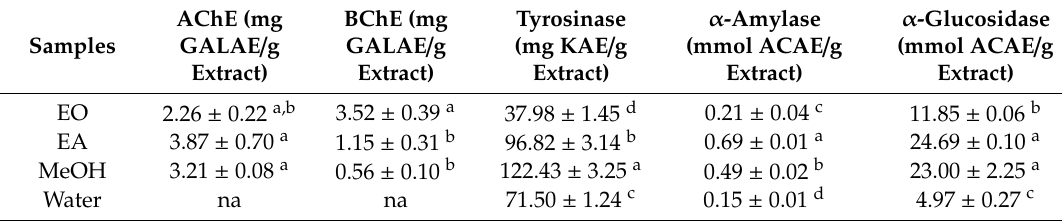
Table 4. Enzyme inhibitory properties of the tested